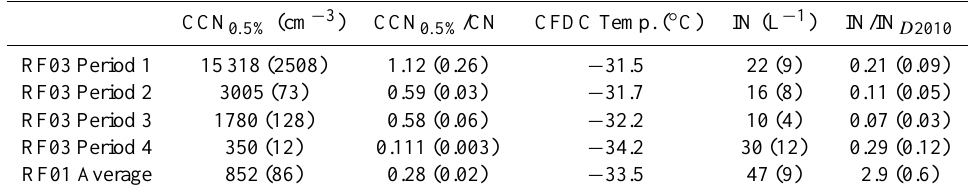
Table 4. CCN number concentrations are shown (with standard deviations), as well as the fraction of CN ( > 13nm) activating as CCN, at 0.5% supersaturation with respect to water; the average CCN/CN value > 1 is physically impossible and shows the uncertainty associ- ated with the measurements and time synchronization. Measured IN number concentrations (with 95% confidence intervals) are shown for immersion/condensation freezing IN at the noted CFDC processing temperatures. IN/IN D 2010 described the measured IN number concen- tration divided by that predicted by the parameterization of DeMott et al. (2010). RF03 Periods 1–4 and the RF01 average correspond to approximate aerosol ages of ∼ 2–4min, ∼ 32–39min, ∼ 52–62min, ∼ 81–88min, and ∼ 17–30min,